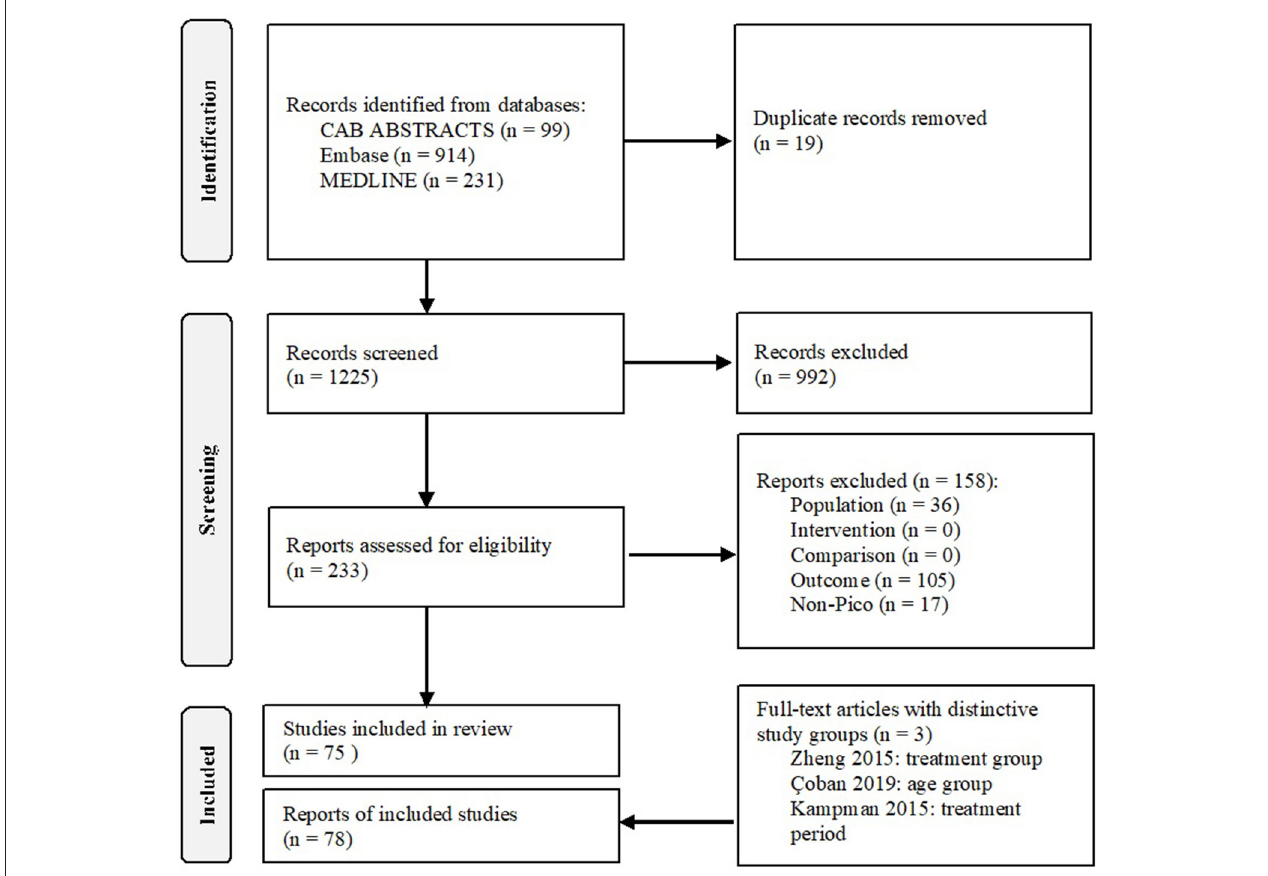
FIGURE 1 | Flowchart. Used under the Creative Commons Attribution License terms, adapted from (22).